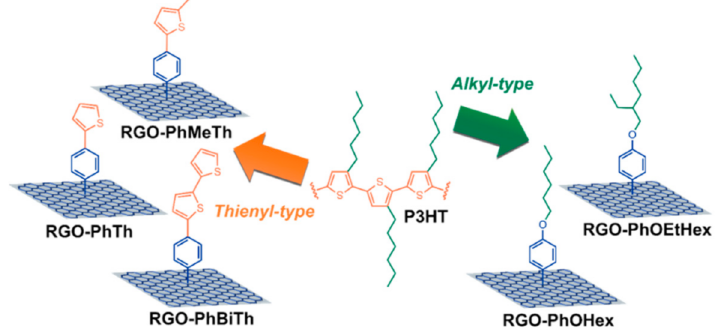
Figure 11. Schematic illustration of the five types of functionalized RGO species reported in this work, highlighting the similarity of relationships existing among the organic substituents covalently bound to RGO and the P3HT structure. Reproduced from [98] with the permission of